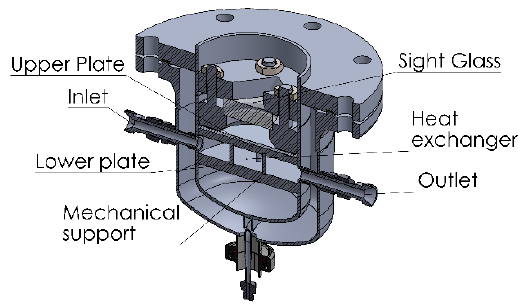
Figure 2. Double walled evaporator/condenser.